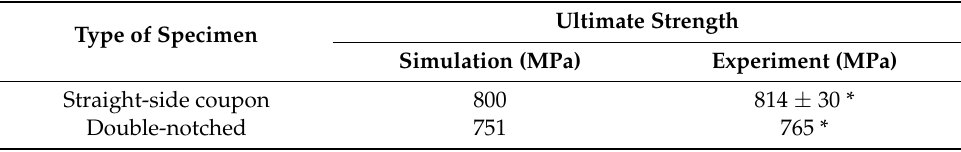
Table 5. Comparison of simulation predicted and experimental measured the effective tensile strength of the triaxially-braided composite.